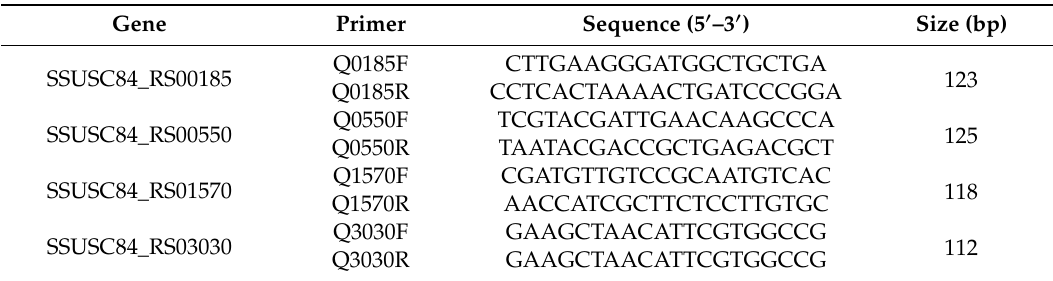
Table 1. Primers used for qRT-PCR